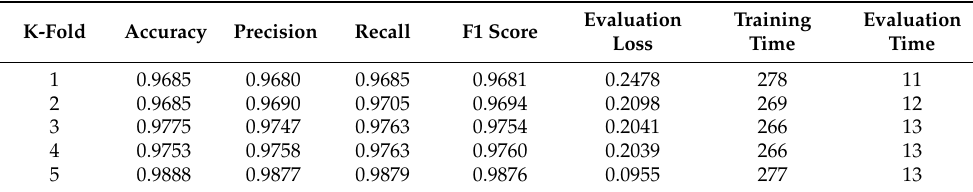
Table 11. DistilBERT—BBC Text dataset.